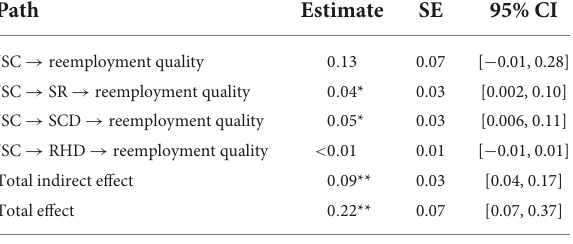
TABLE 4 Mediation effects of reemployment crafting on the relationship between JSC and reemployment quality.